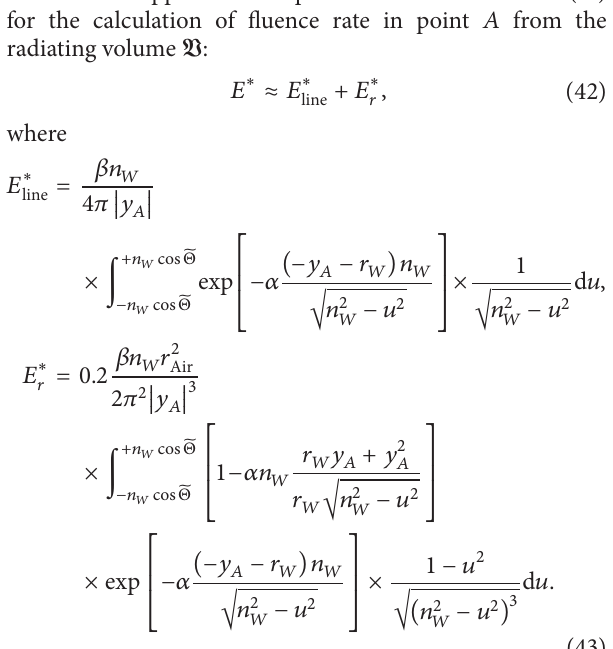
Figure 6: Explanatory draft for the definition of effective interval.